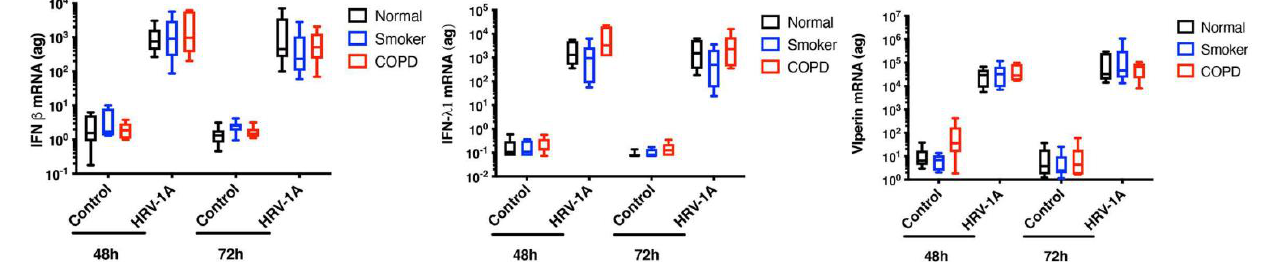
Figure 2. Exposure of bronchial epithelial cells from COPD patients, healthy smokers and non- smokers to rhinovirus-1A lead to similar levels of IFN β , IFN- λ 1 and viperin induction ( n = 6). Bronchial epithelial cells were obtained by bronchial brushings. Cells were infected with rhinovirus for 48 h or 72 h. Levels of mRNA were assessed by real-time PCR.